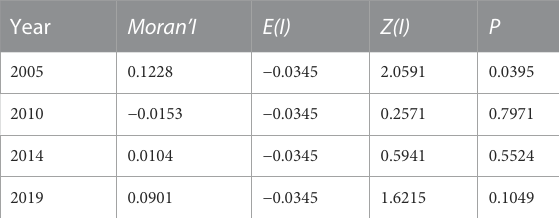
TABLE 4 Global Moran ’ I